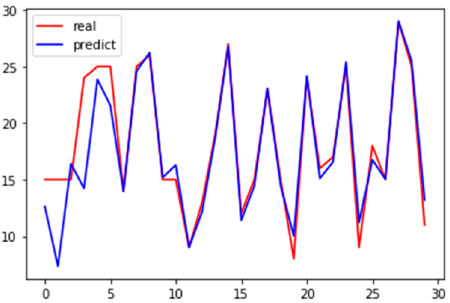
Figure 12. Performance of the model on validation set.